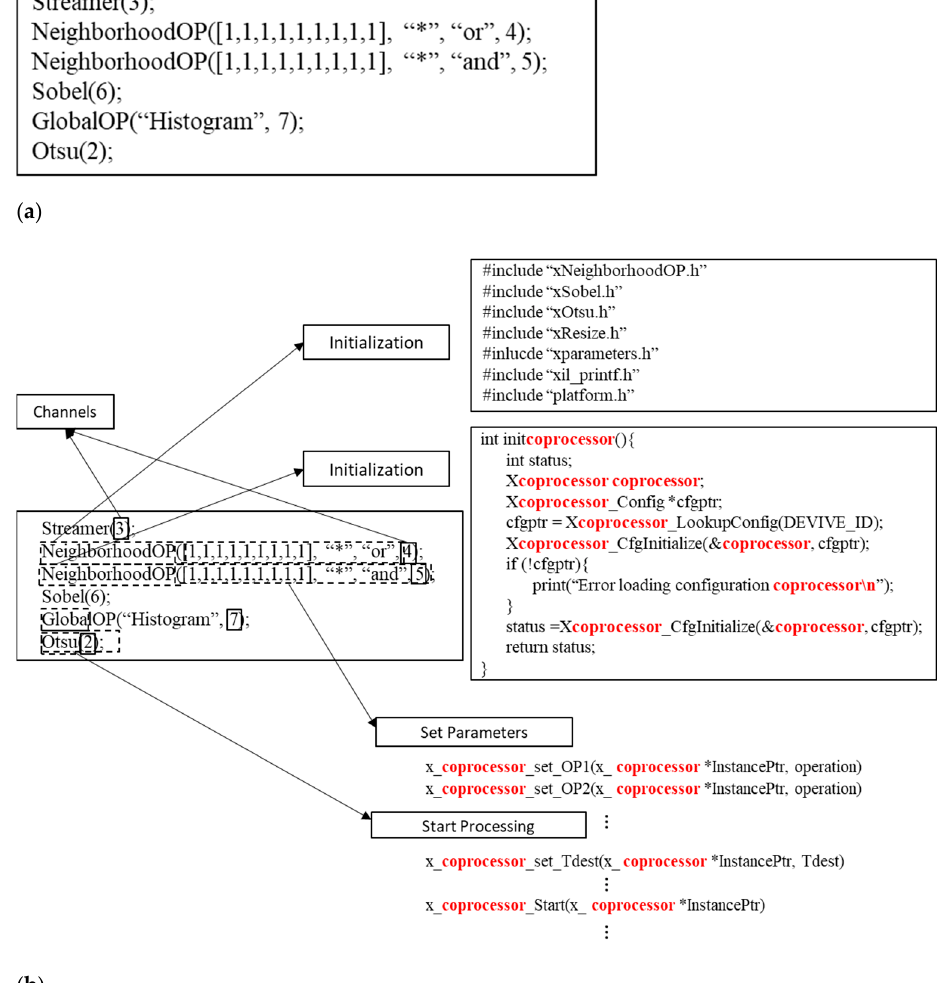
Figure 4. ( a ) Example of the textual description of a DFG for Otsu after an Open operation. ( b ) Exam- ple of the code generated by the TCG tool from the DFG in Figure